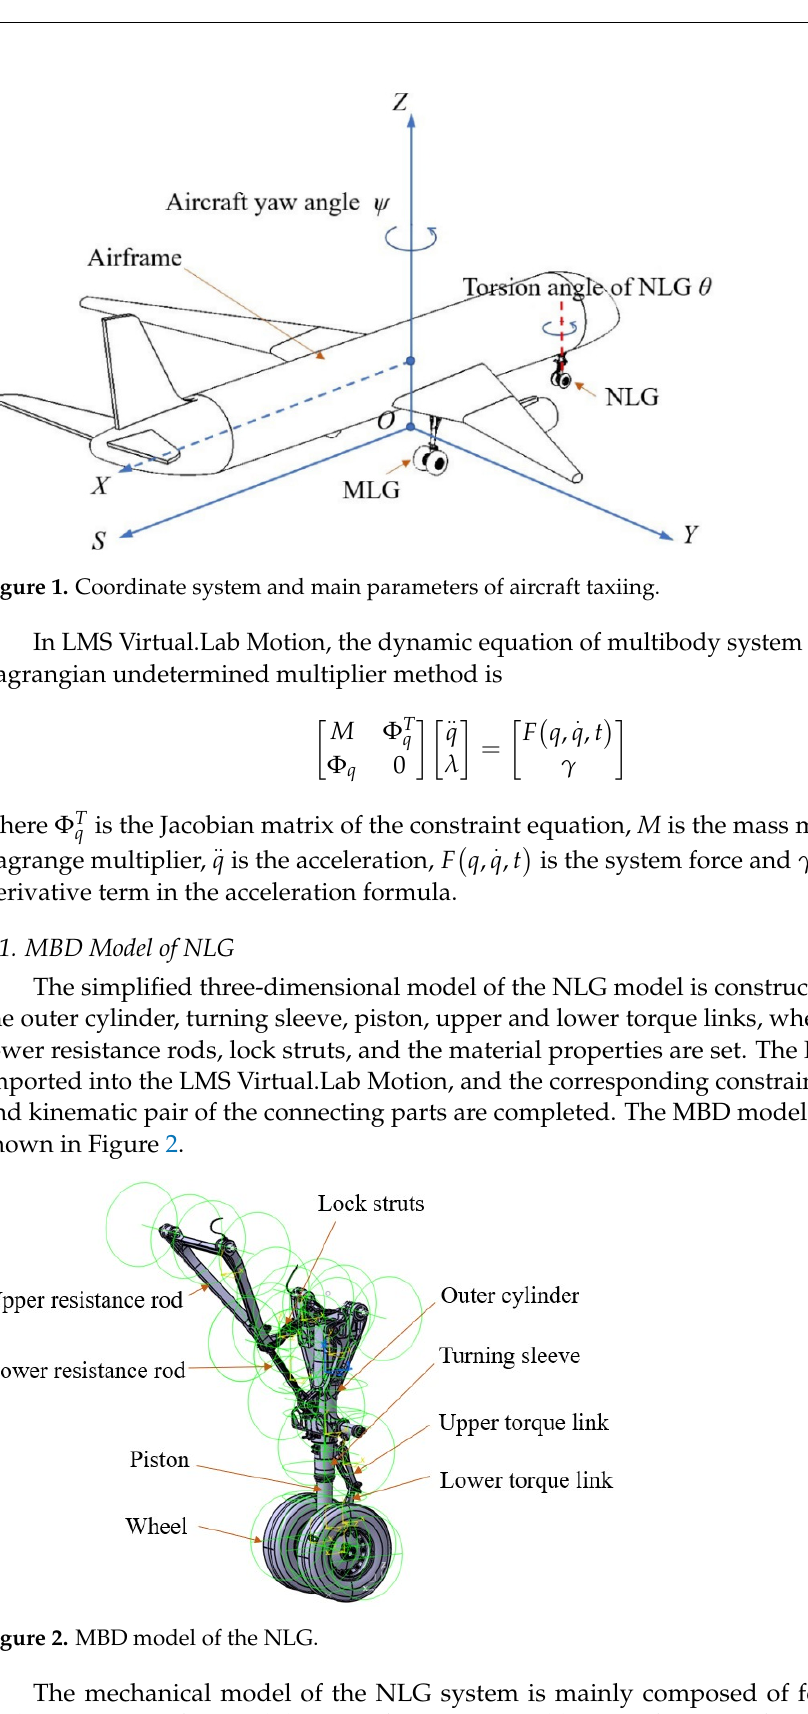
Figure 2. MBD model of the NLG.